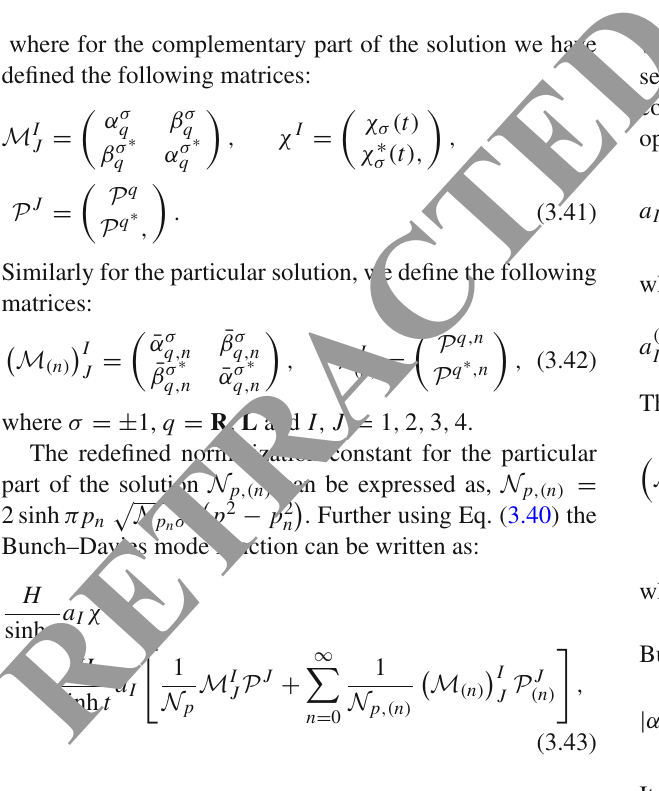
Fig. 8 Schematic diagram for the computation algorithm of reduced density matrix formalism for mixed quantum state of axion in de Sitter hyperbolic open